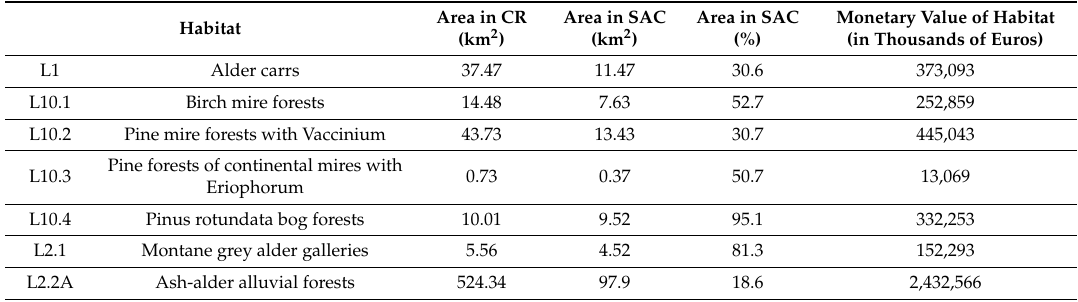
Table 2. Area and monetary value of natural forest habitats in the Czech Republic.